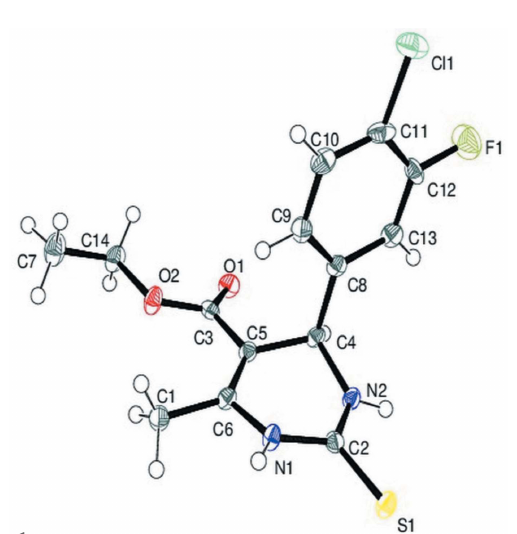
Figure 1 The molecular structure of the title compound, with displacement ellipsoids drawn at the 50% probability level.